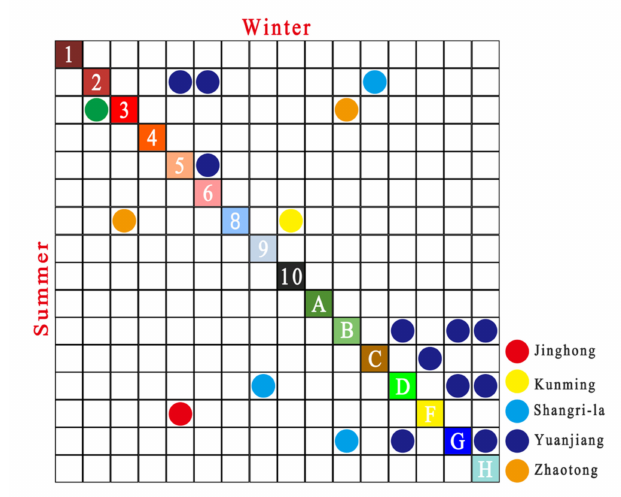
Figure A3. Multiple-comparison results of the differences in the mean LST among the various LCZ types (white numbers and letters). The solid-colored circles represent no significant difference in mean LST, and the hollow cells show that the mean LSTs of the given LCZ pairs were significantly different.